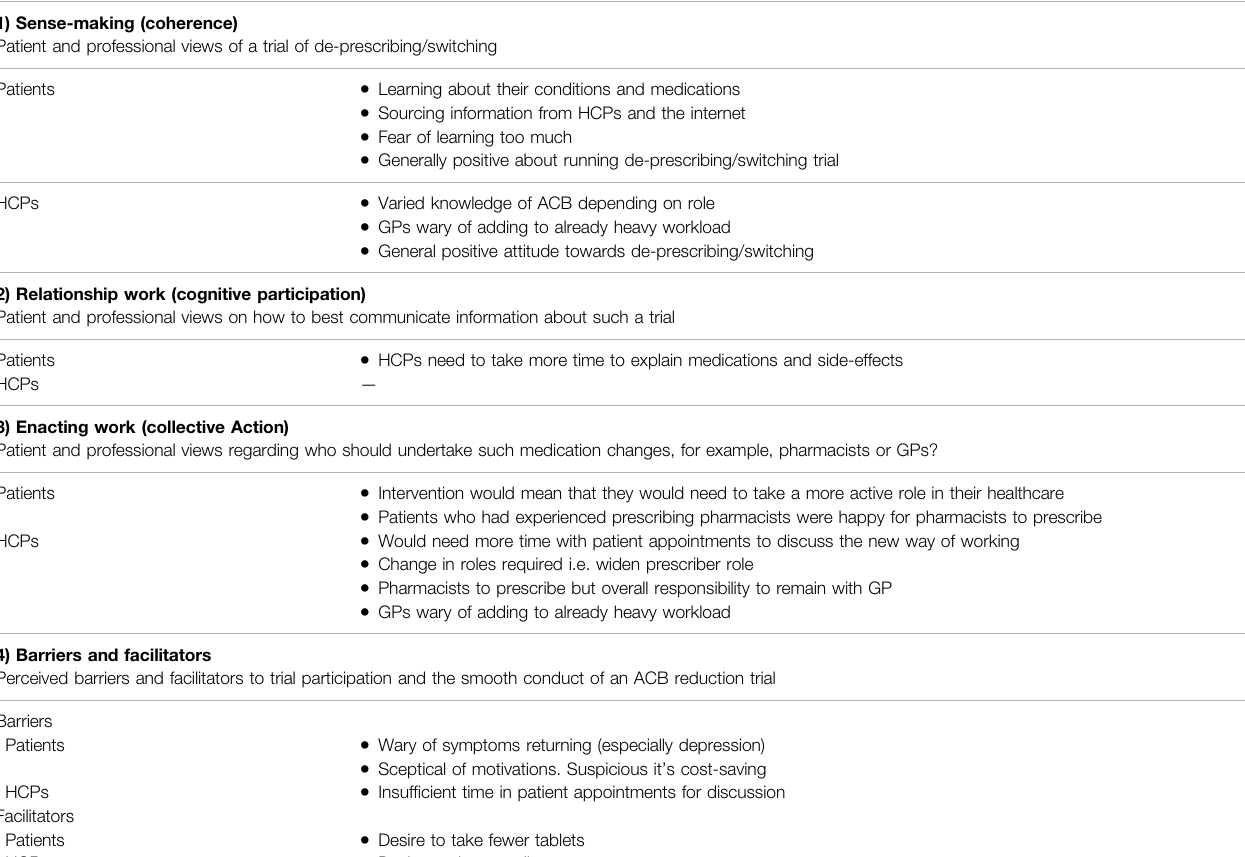
TABLE 2 | Summary of fi ndings from interviews and focus